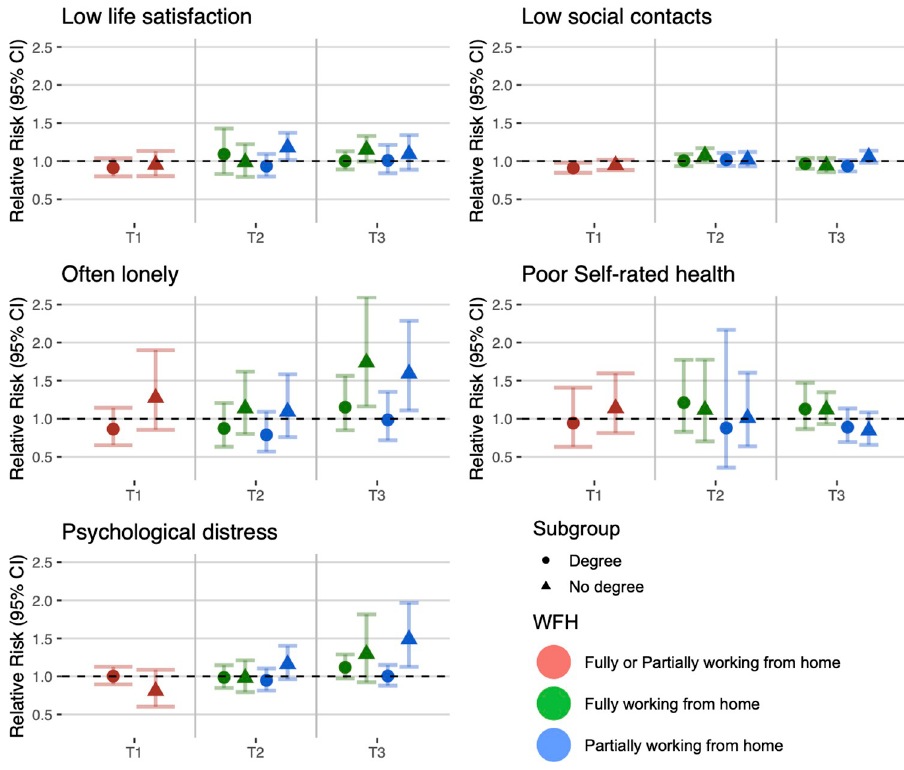
Fig 5. Stratification by highest level of